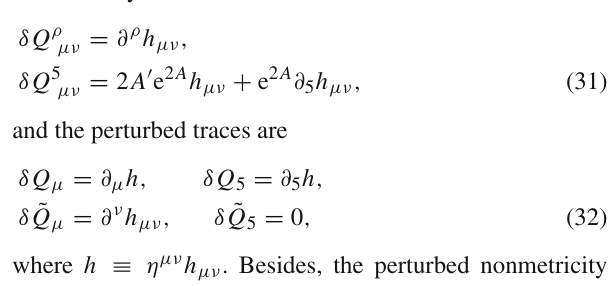
Fig. 1 Theshapesofthewarpfactore 2 A ,backgroundscalarfield φ( y ) , scalar potential V (φ) , and energy density ρ( y ) for the first brane solu- tions. The parameters are set to κ = φ 0 = 1, k = 1 for blue short dashed lines, k = 2 for black lines, and k = 3 for red long dashed lines